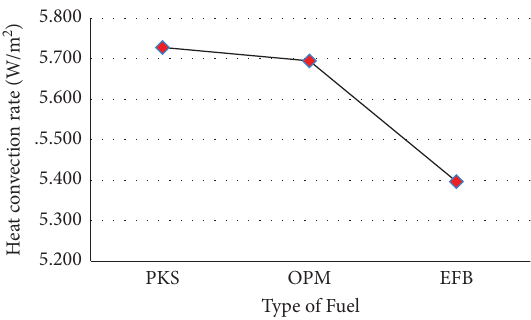
Figure 13: Heat convection rate for different fuels at the measurements (M-IV).